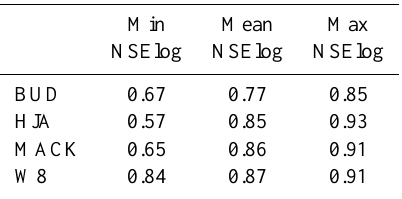
Table 5. Effectiveness of end-member parameters for the WC